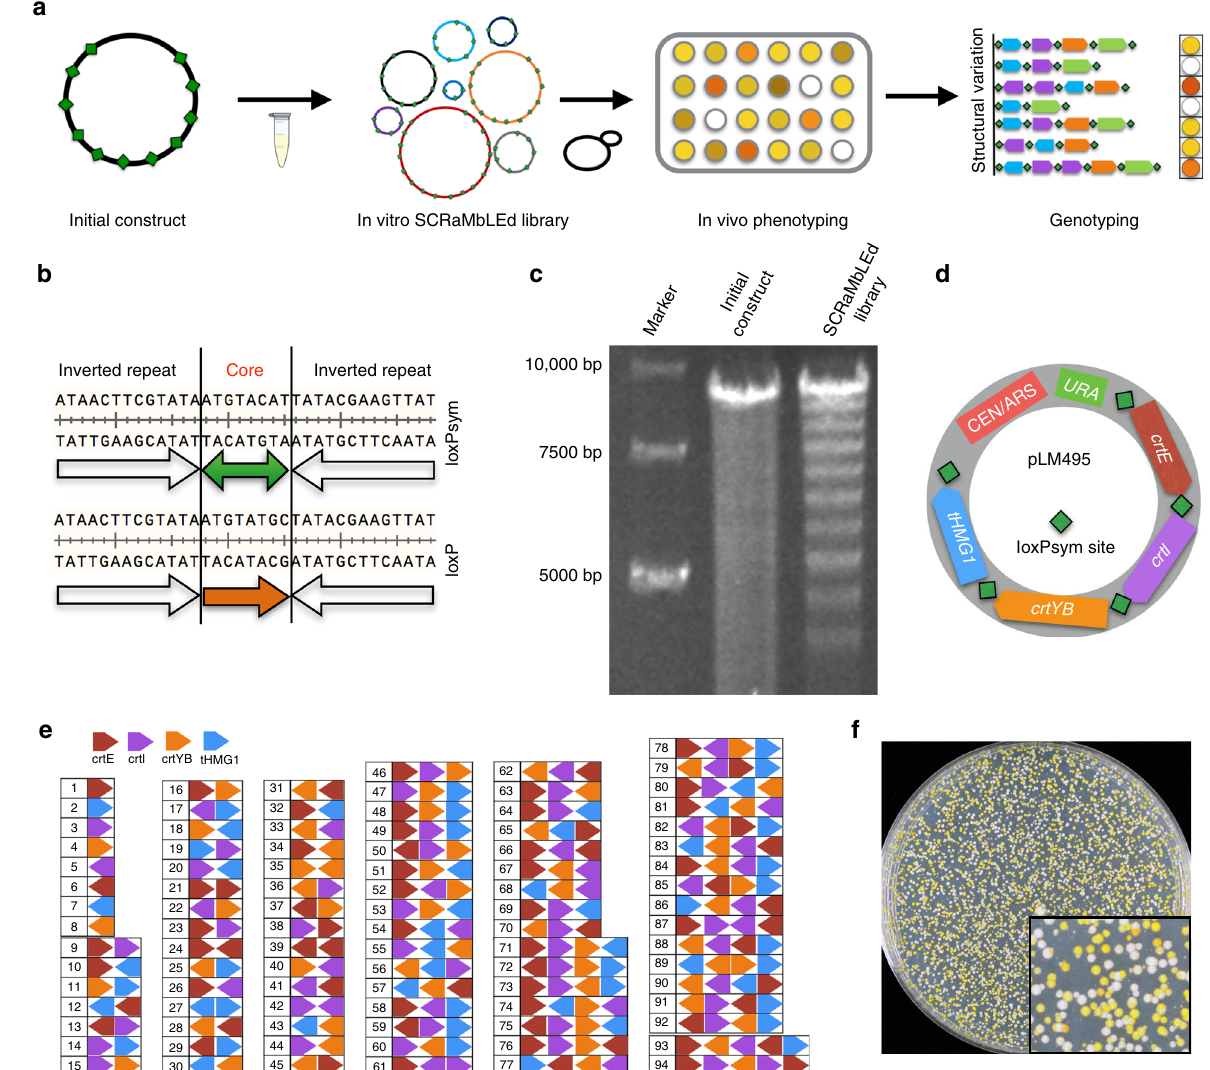
Fig. 1 Top-down in vitro SCRaMbLE. a Schematic of top-down in vitro SCRaMbLE. Green diamonds represent the 34 bp loxPsym site. b Sequence comparison between loxPsym and loxP sites. c Gel electrophoresis analysis of an in vitro SCRaMbLEd library. The parental construct encoded 10 loxPsym sites with an inter-site distance of 500 bp. Material for linearization with Not I was extracted from a pool of E. coli colonies carrying the SCRaMbLEd DNA. d Map of pLM495. LoxPsym sites fl ank the β -carotene pathway genes crtE , crtI , crtYB, and tHMG1 . Transcription units for these genes are pTIP1-crtE-tACS2 , pPGK1-crtI-tASC1 , pTDH3-crtYB-tCIT1 , pZEO1-tHMG1-tACS2 . e A total of 94 unique pathway structures were determined by PacBio sequencing of a SCRaMbLEd pLM495 library. f Yeast colonies transformed with in vitro SCRaMbLEd pLM495. The magni fi ed region shows different colony colors, consistent with production of colored carotenoid intermediates. Synthetic complete medium lacking uracil (SC – Ura) medium was used to select